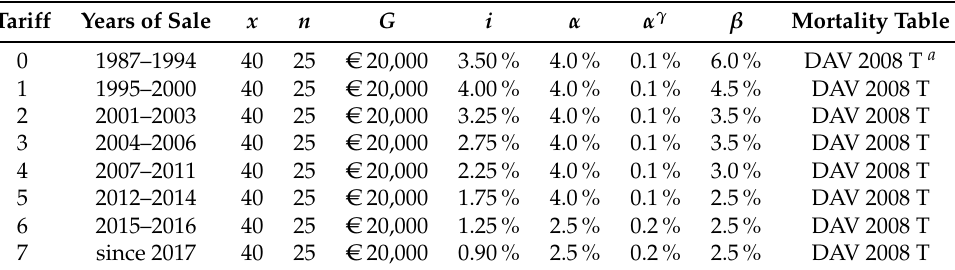
Table 2. Insurance contract parameters.